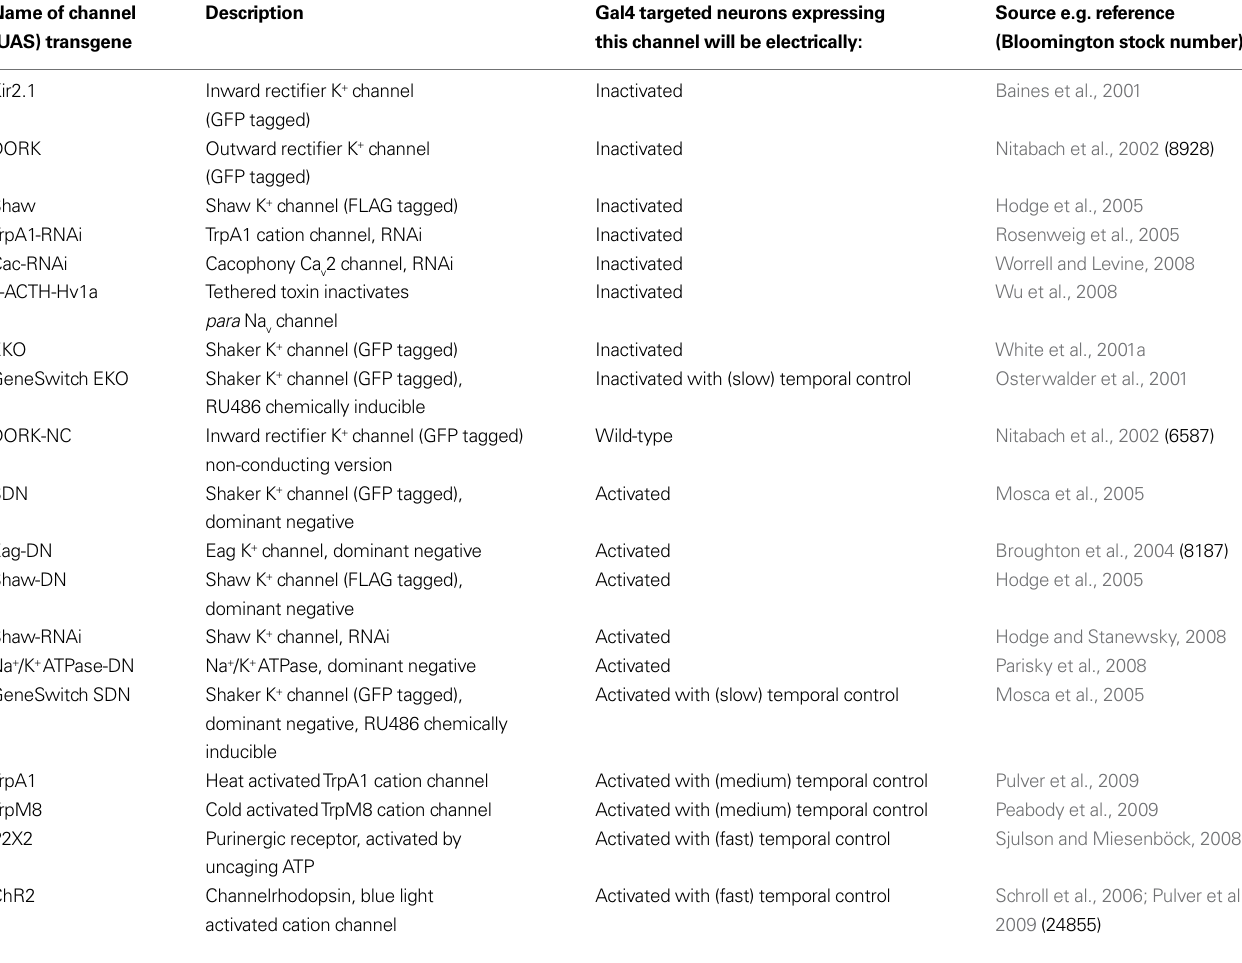
Table 1 | Summary of ion channels to manipulate neuronal activity in Drosophila